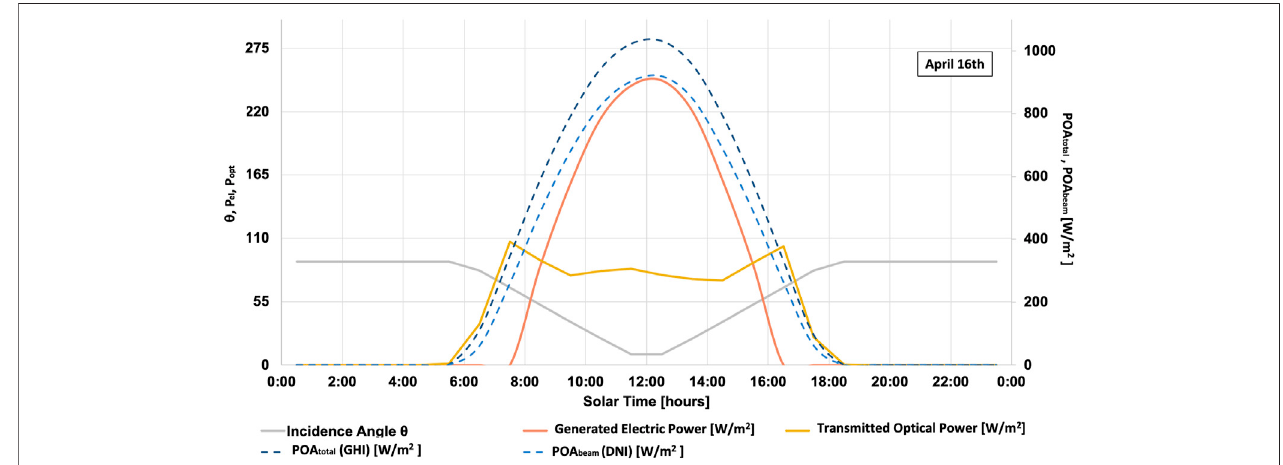
FIGURE 9 | Electric power and Transmitted optical power on April 16th.